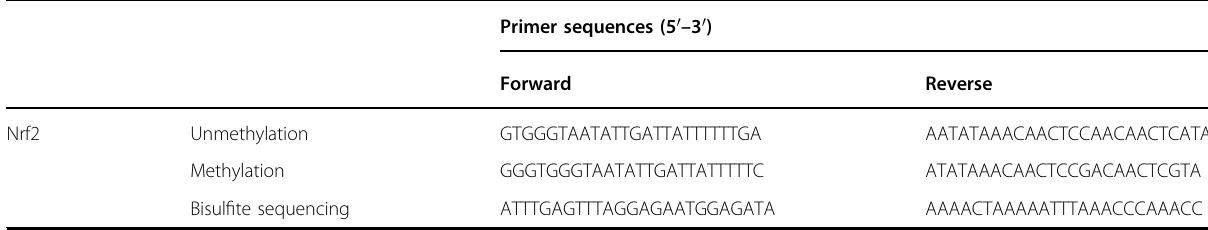
Table 1 Primer information for methylation analyses of Nrf2